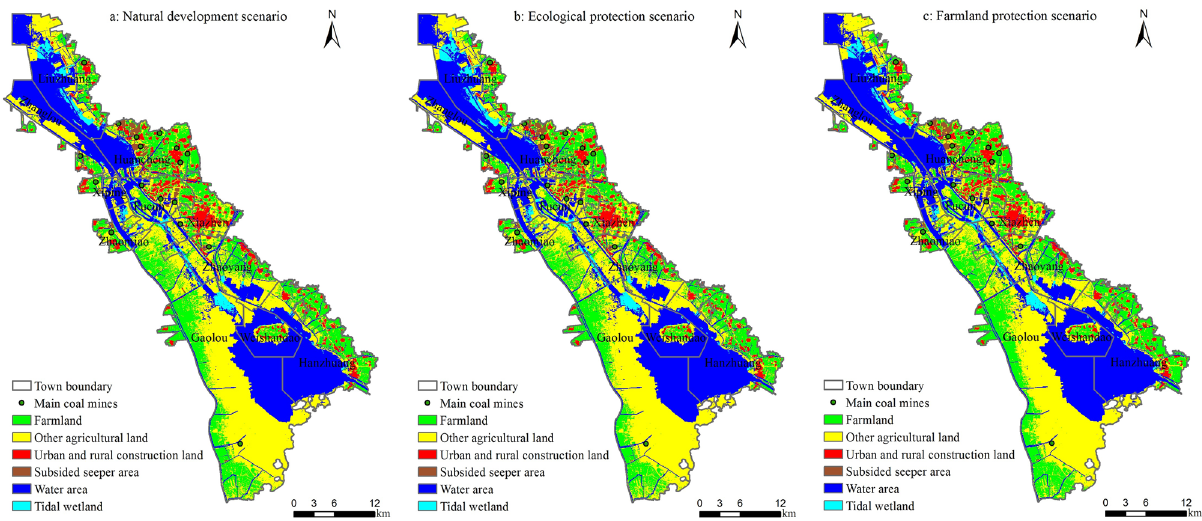
Figure 5. LULC simulation maps in 2025 under different scenarios. Maps were generated using ArcGIS 10.1 for Desktop (http:// www. esri. com/ softw are/ arcgis/ arcgis- for- deskt